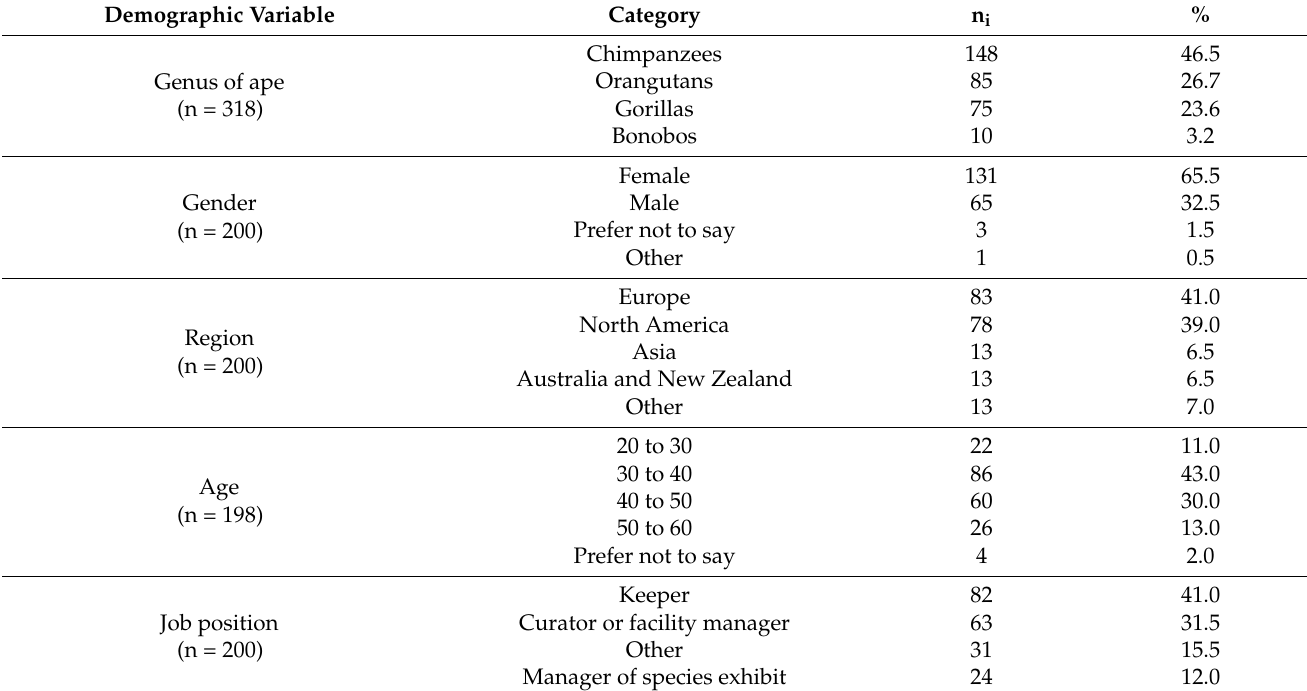
Table 2. Respondent demographics from a 43-question, online survey. ”n” indicates the total number of responses per question and ”n i ” represents the number of responses for each variable. The number of paid, full-time employees (FTE) represented the size of the